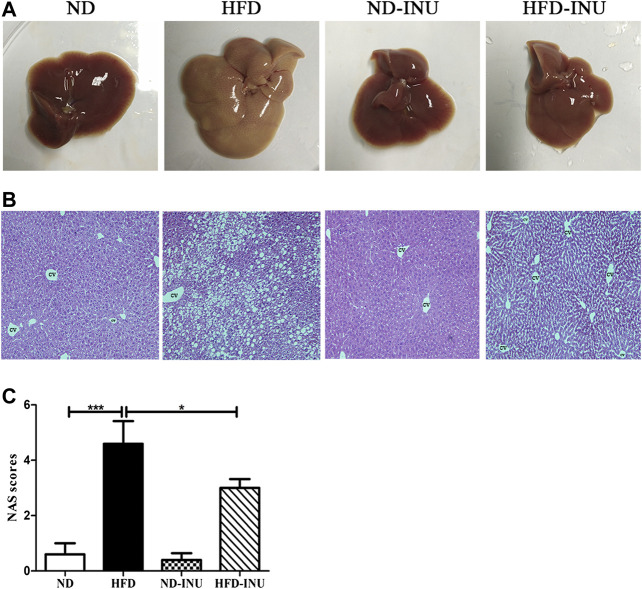
Effects of INU treatment on liver injury in NAFLD. (A) Liver appearance. (B) Representative images of hepatic hematoxylin and eosin (H&E) staining. (C) NAS. Data are expressed as mean ± SEM. *p < 0.05, **p < 0.01, ***p < 0.001. CV: central vein. Original magnification, ×200. All experiments were performed in triplicate. NAS: NAFLD Activity Score; INU: inulin; ND: normal diet; HFD: high-fat diet.